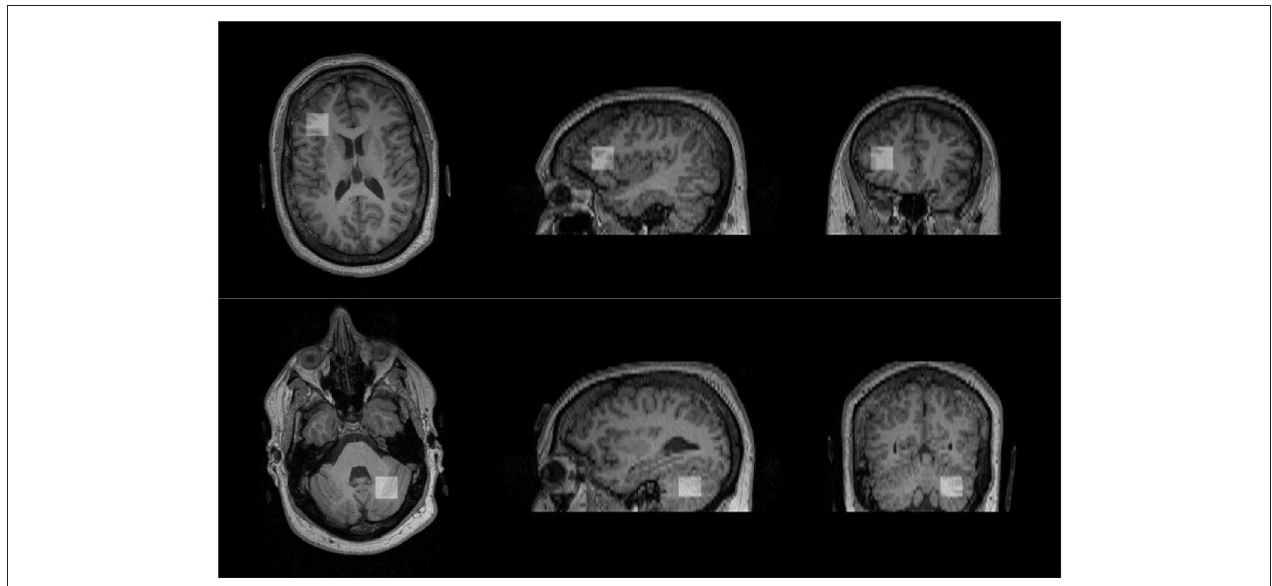
FIGURE 1 | Approximate positions of voxels placed in the regions of interest. Voxel of interest (indicated by white square) placed in the left dorsolateral prefrontal cortex (top) and the right cerebellum (bottom).